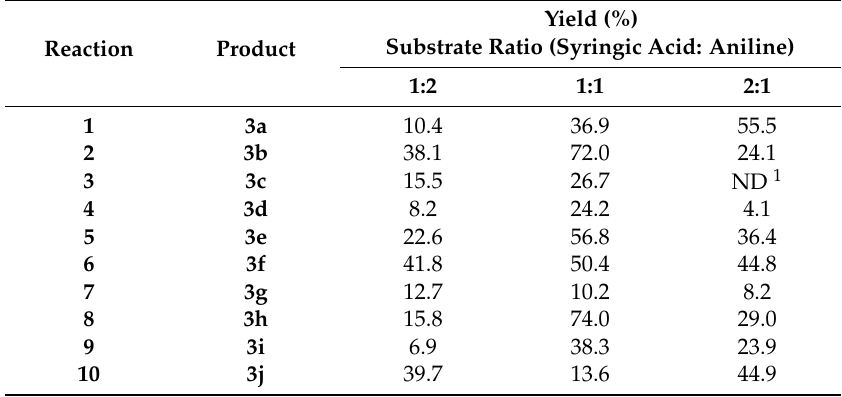
Table 1. Percentage yields of products at different reactant ratios.